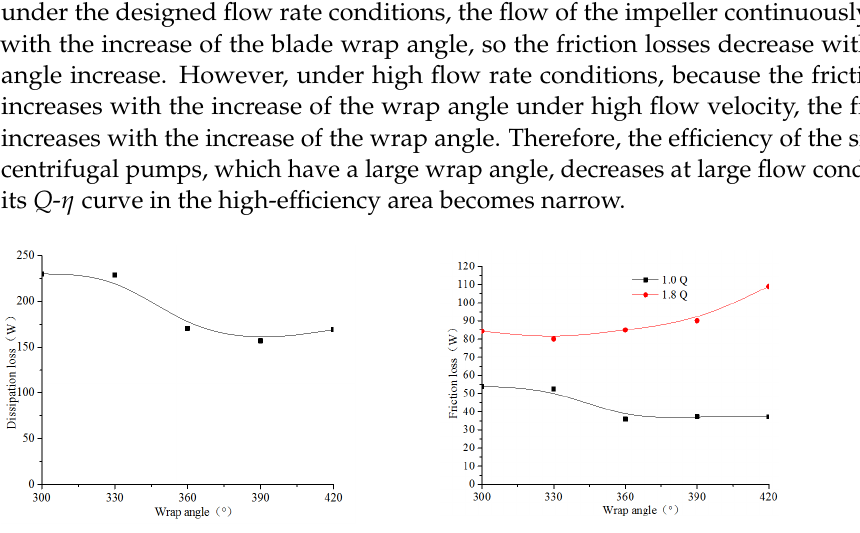
Figure 9. Energy loess of single blade centrifugal pump with different wrap angles.